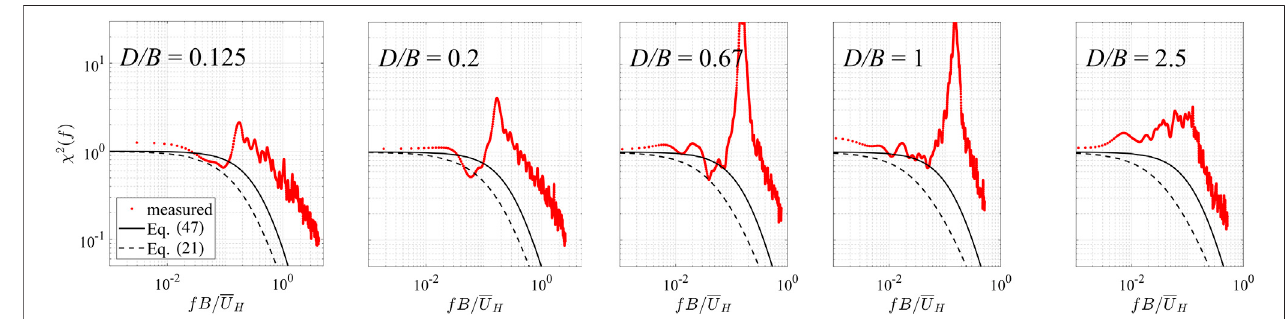
FIGURE 6 | Aerodynamic admittance functions for area-averaged fl uctuating pressure coef fi cients on the side wall. Legends: measured, Eq. 47 , Eq. 21 .